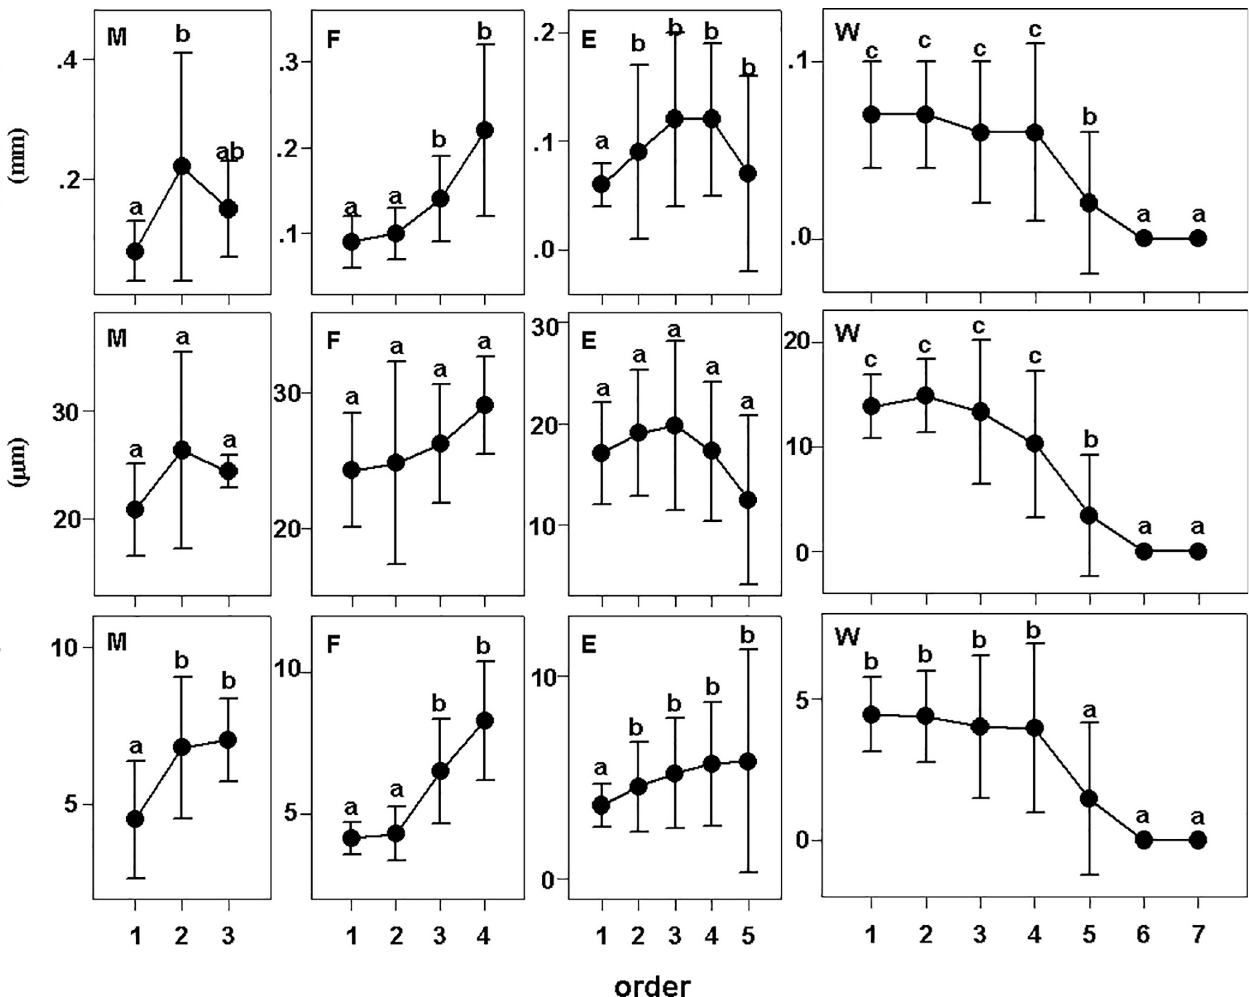
Fig 3. Cortical thickness, diameter of cortical cells and number of cortical cell layers of fine roots in different groups. Different lower-case letters indicate significant differences (P < 0.05) among orders. The error bars represent 1 SD of the mean. M: Monocots; F: Fern; E: Eudicot herbs; W: Woody plants.